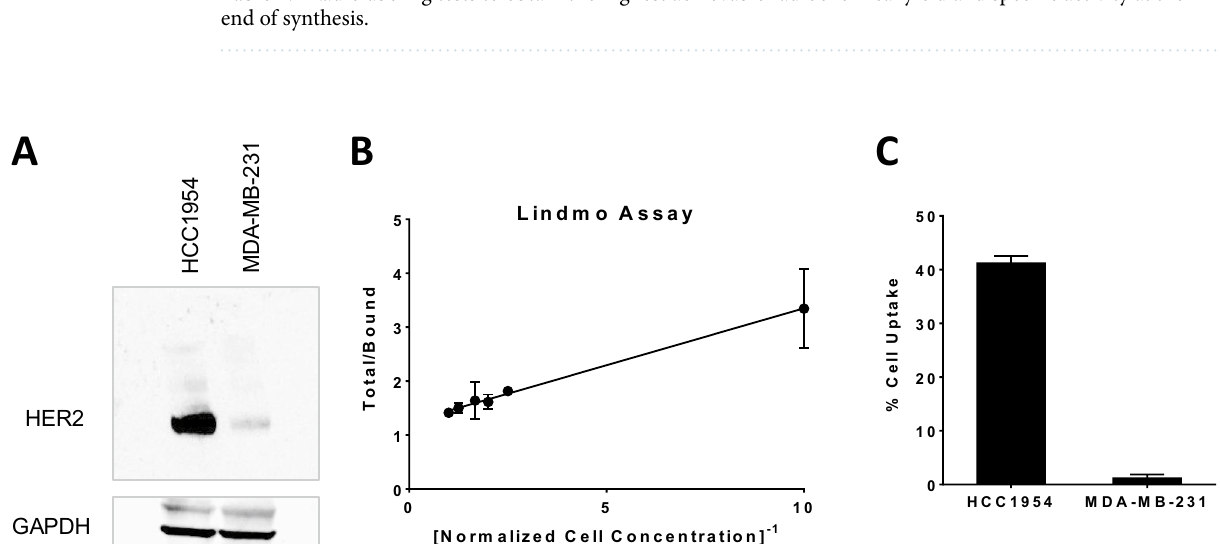
Figure 2. The immunoreactivity of pertuzumab was not compromised after NOTA conjugation and 67 Cu-labeling. ( A ) Western blot analysis of HER2 positive HCC1954 and HER2 negative MDA-MB-231 cells (the blots are cropped for clarity. The full length blots at different exposure levels are presented in Supplementary Figure S1); ( B ) Lindmo assay of [ 67 Cu]Cu-NOTA-Pertuzumab using HCC1954 cells; ( C ) Cell uptake assay of [ 67 Cu]Cu-NOTA-Pertuzumab in HCC1954 and MDA-MB-231 cells. ( B ) was graphed with GraphPad Prism 7.0 (https ://www.graph pad.com/scien tific -softw are/prism